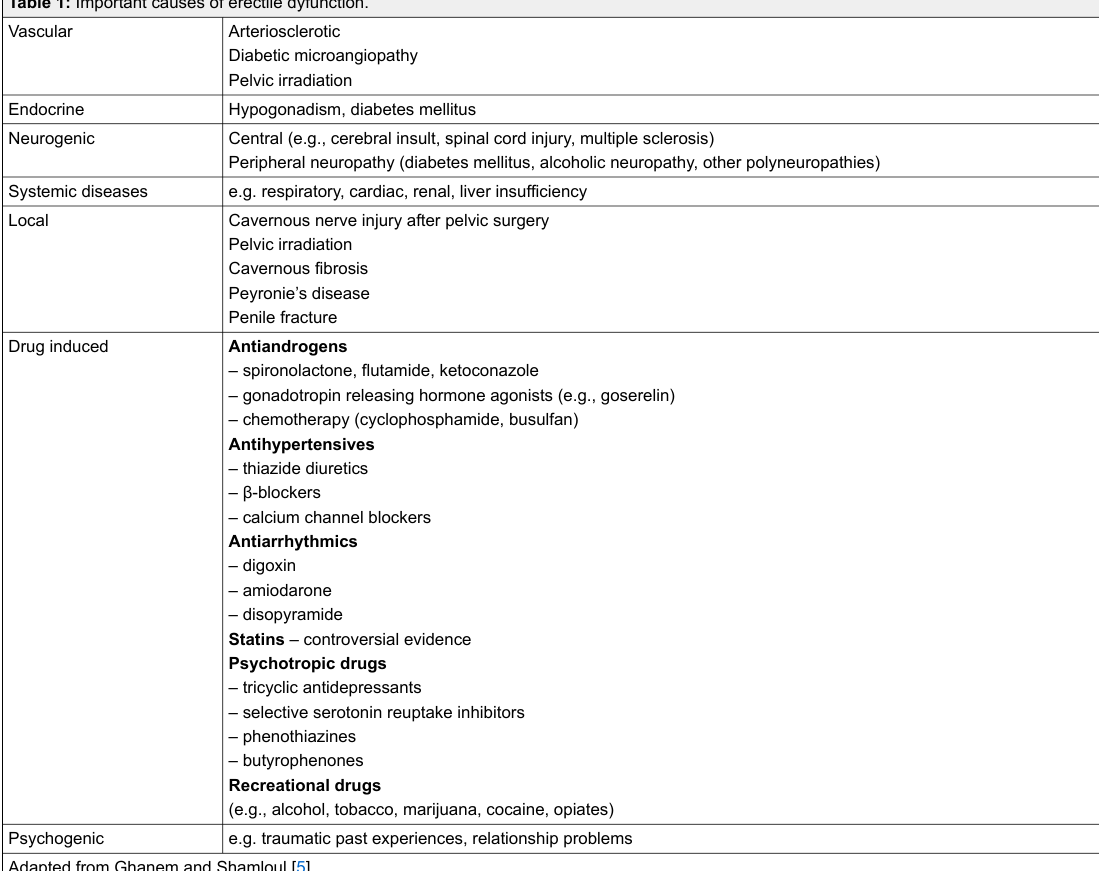
Table 1: Important causes of erectile dyfunction.